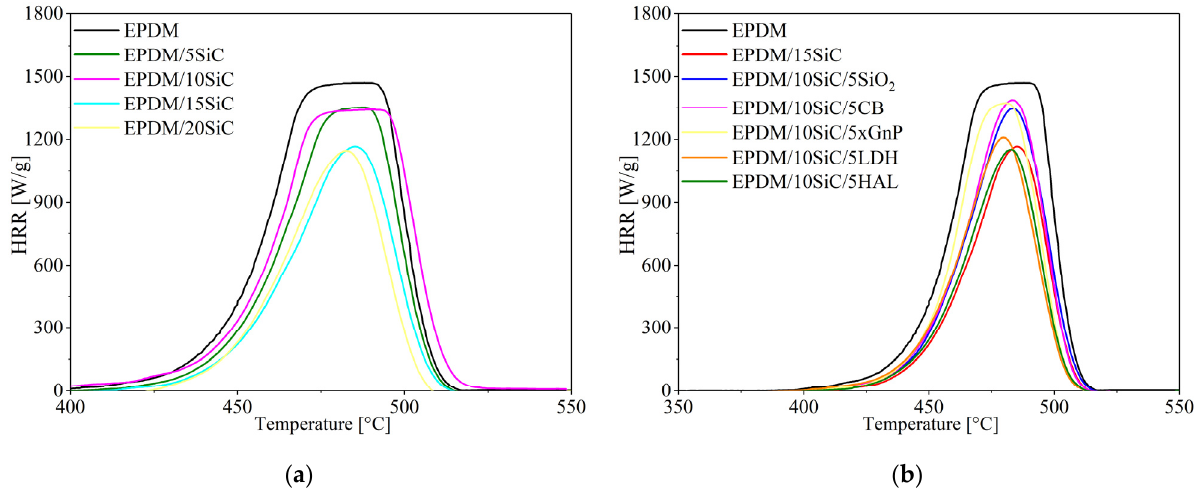
Figure 9. HRR curves of the EPDM composites filled with SiC ( a ) and its hybrid filler systems ( b ). Table 5. Results of microscale combustion calorimetry (MCC) tests on EPDM-filled composites.